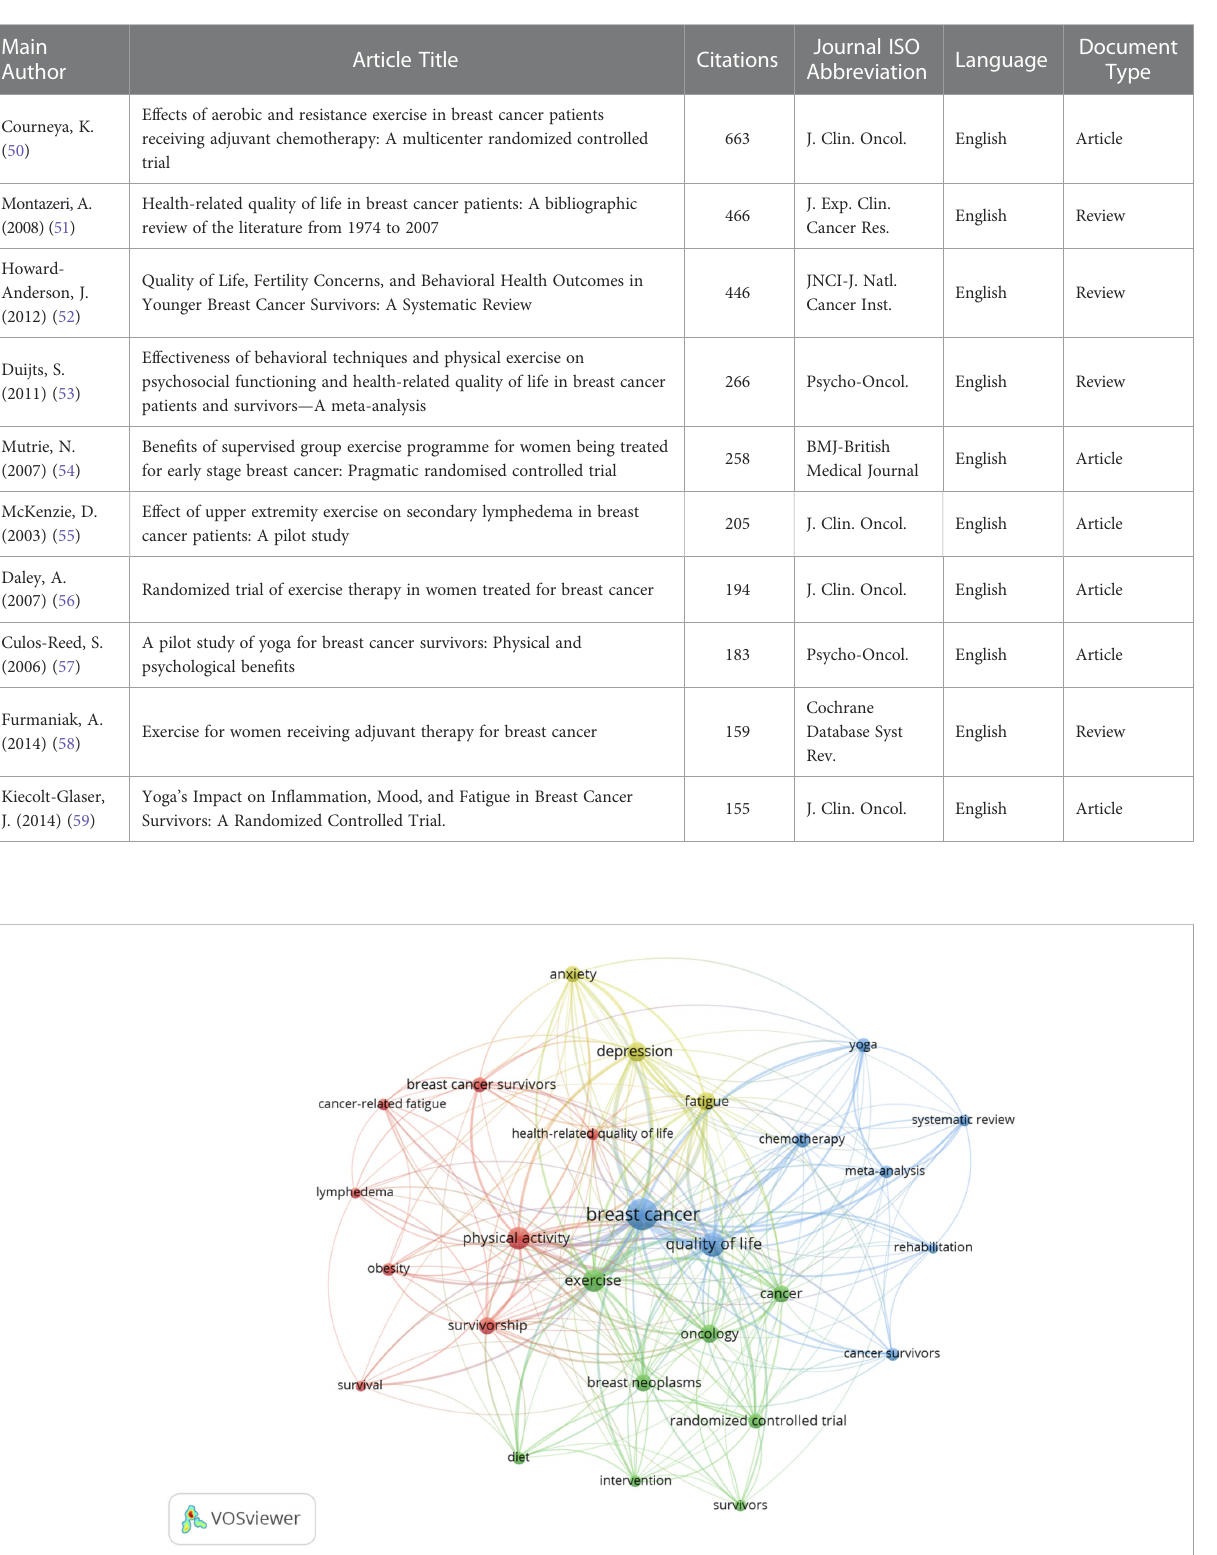
TABLE 2 The 10 most cited articles.